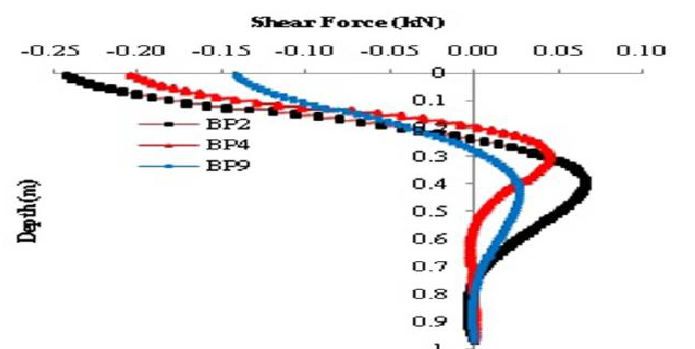
Fig. 19. Predicted different pile group shear force results at 3D pile spacing of bamboo pipe piles for slenderness ratio as 38.